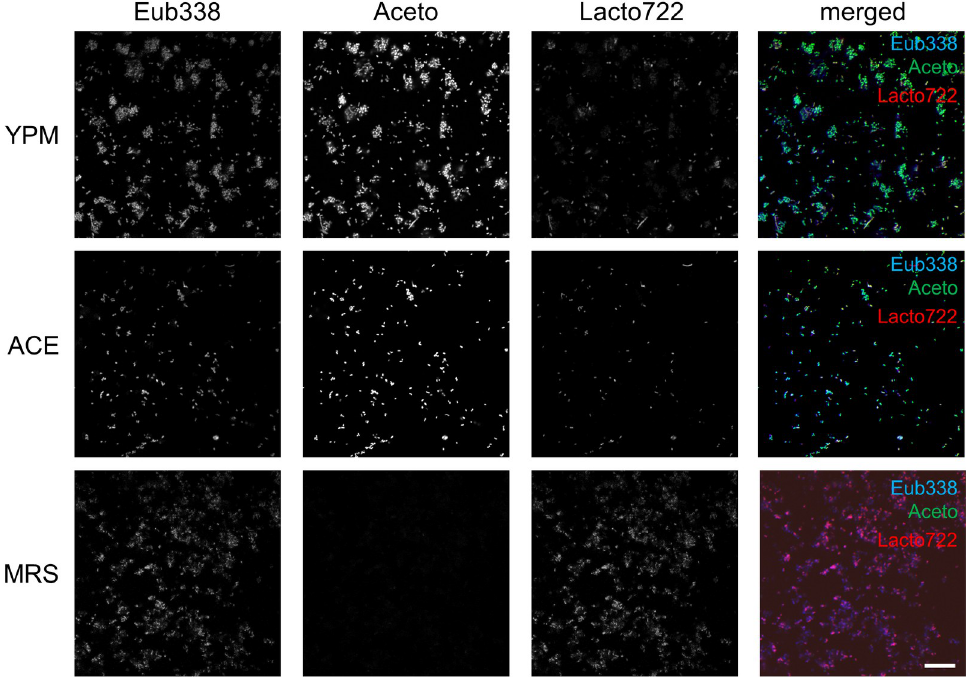
Fig 2. Fluorescence in situ hybridization with isolated Drosophila gut microbiomes. FISH was performed with PFA- fixed isolated Drosophila gut bacteria using the three different probes Eub338 (blue), Aceto (green), and Lacto722 (red) (4 μ M/probe) and 40% formamide for three hours at 46˚C. The isolates were treated with 10 mg/ml lysozyme for 15 minutes at 37˚C prior to the hybridization. Bacteria were cultured in either YPM-, ACE- or MRS-medium. The figure shows representative examples from at least three separate experiments. Scalebar represents 20 μ